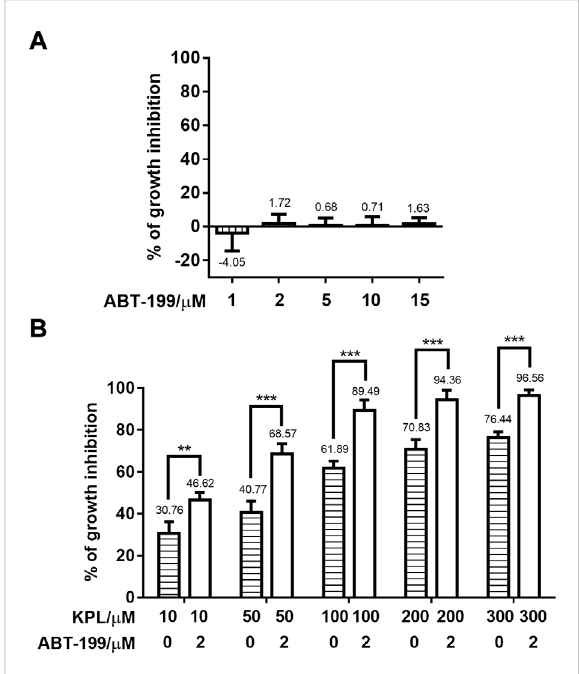
Effect of KPL combined with ABT-199 on the growth inhibition of HepG2 cells. (A) Growth inhibition percentage (%) of different concentrations of ABT-199 against HepG2 cell line. Cells were seeded in a 96-well plate and treated with 1 – 15 μ M ABT-199 for 48 h, and the growth inhibition percentage of cells was detected with CCK-8 kit. (B) Growth inhibition percentage (%) of different concentrations of KPL combined with 2 μ M ABT-199 on HepG2 cell line. Cells were seeded in a 96-well plate and treated with 10 – 300 μ M KPL for 48 h with or without 2 μ M ABT- 199, and thegrowth inhibition percentageof cells was determined by CCK-8 kit. Values are means ± SD ( n = 4). ** p < 0.01, *** p < 0.001 versus the same concentration KPL only